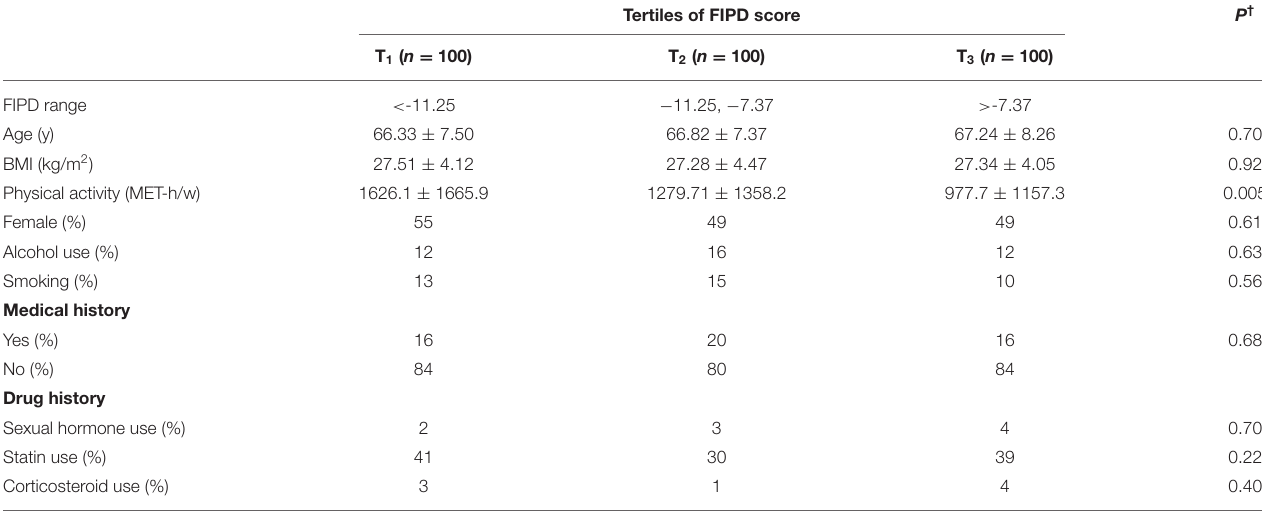
TABLE 1 | Characteristics of study participants in FIPD categories*.